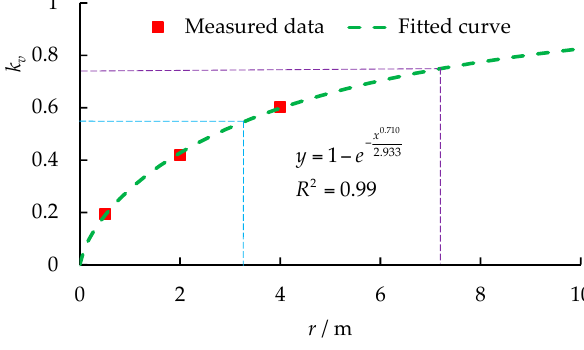
Figure 7. Variation in blasting integrity rate k v with respect to distance r .